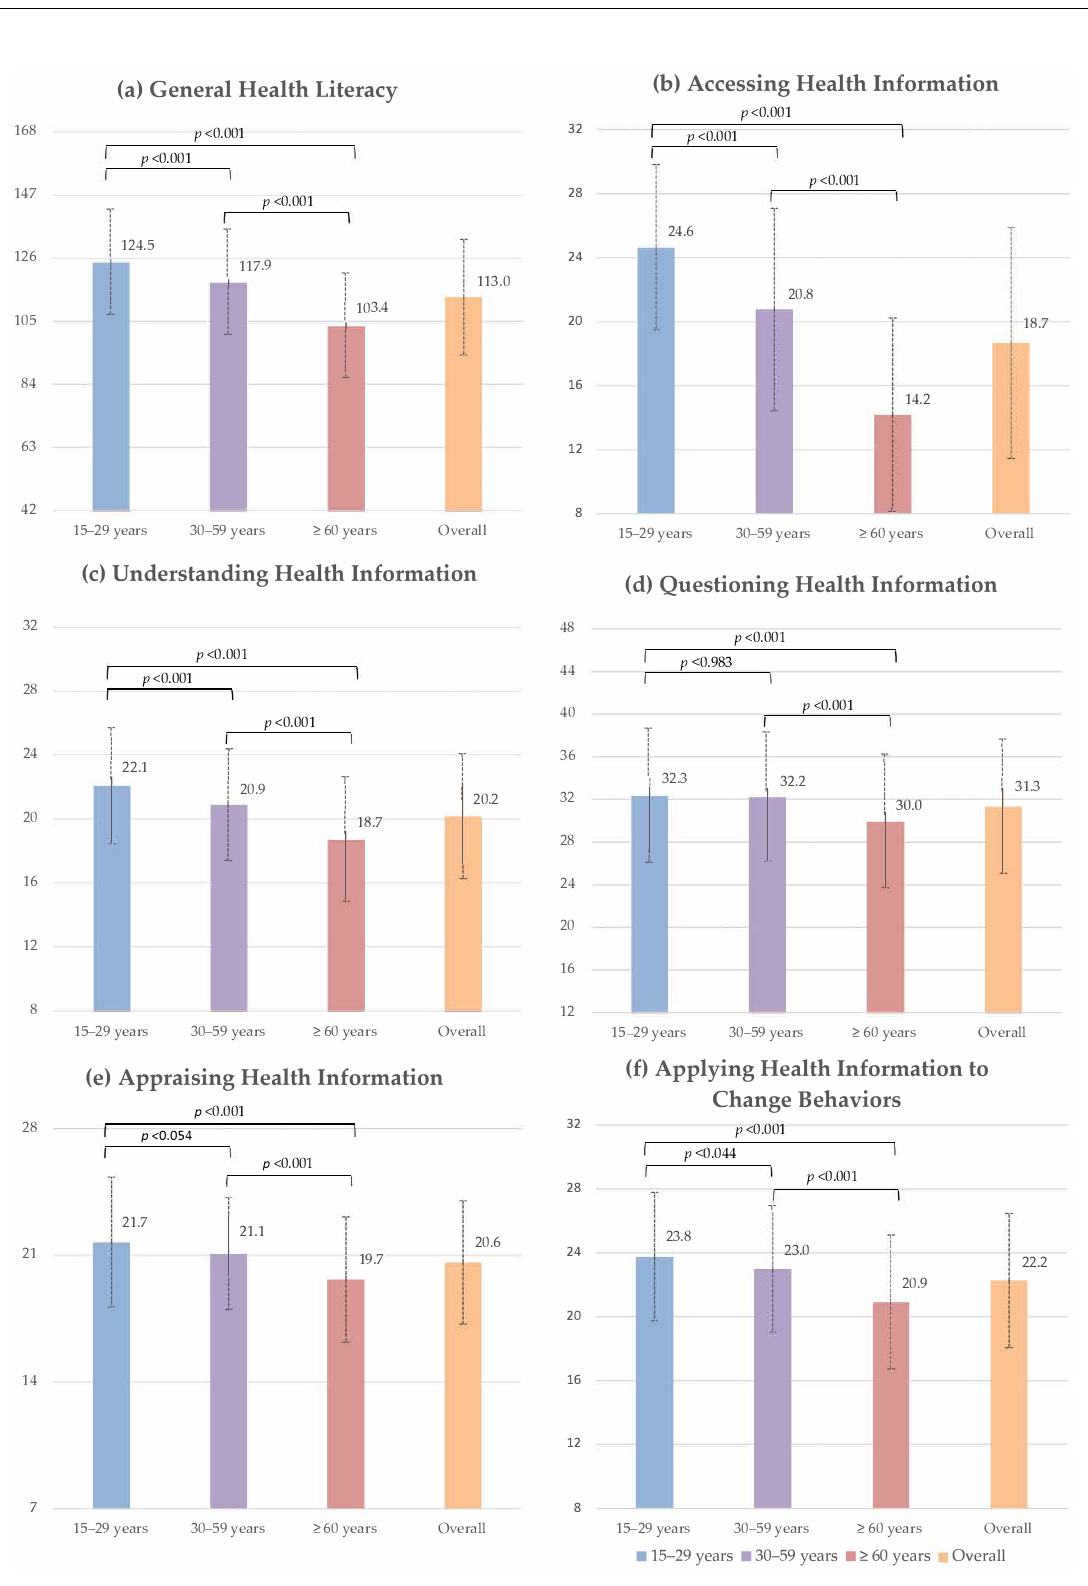
Figure 4. Bar plots illustrating the mean and standard deviation of general and subindices of health literacy stratified by